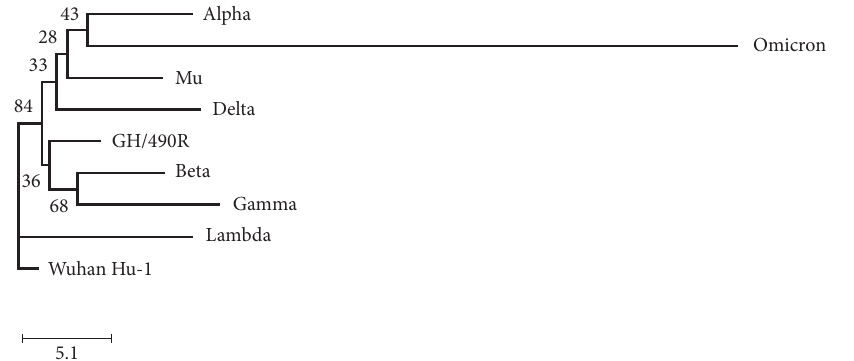
Figure 1: Evolutionary relationships of variants of SARS-CoV-2. The evolutionary history was inferred using the neighbor-joining method [13]. The evolutionary distances were computed using the Kimura 2-parameter method [14]. Evolutionary analyses were conducted in MEGA X [12]. The tree was rooted to